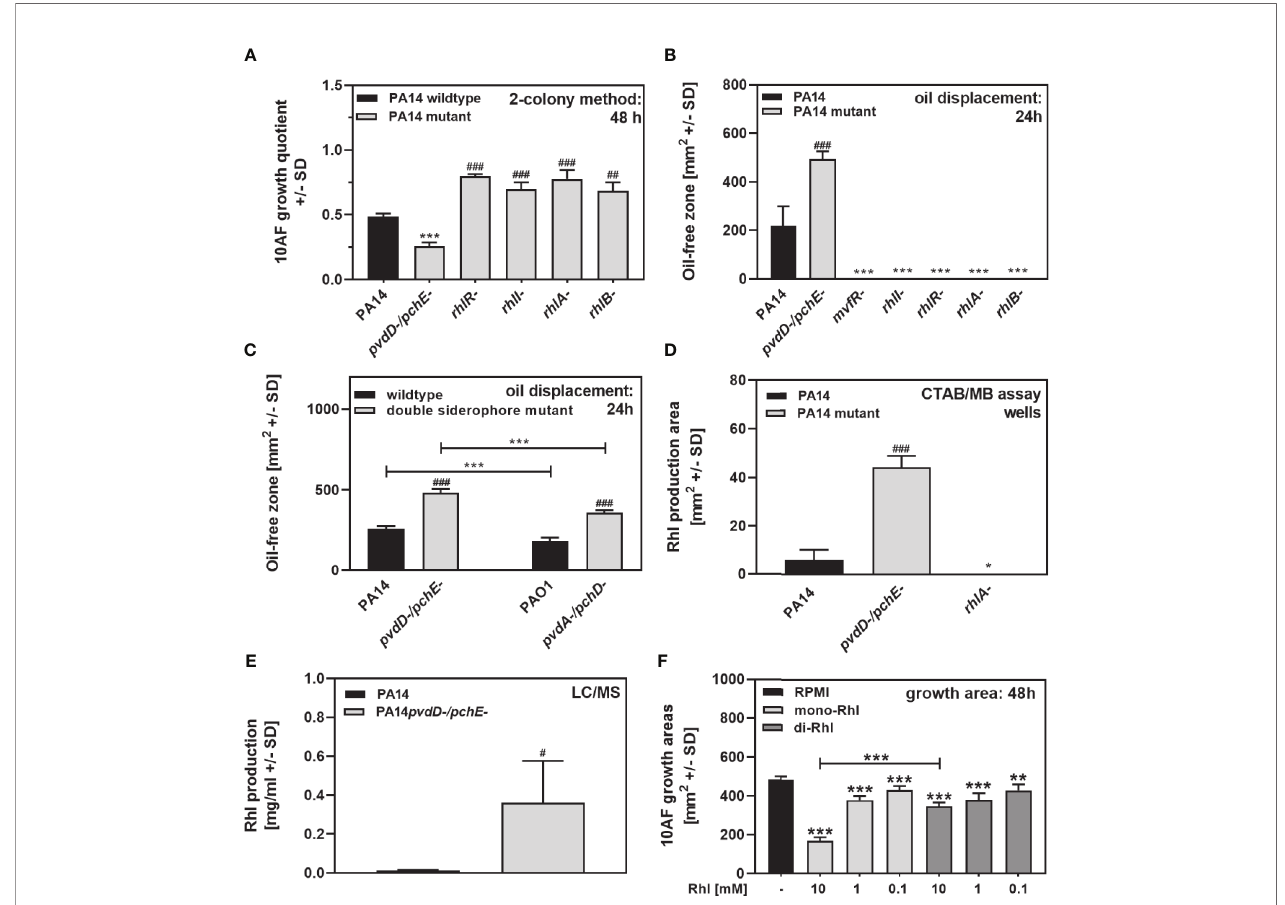
FIGURE 6 | Rhamnolipids have antifungal activity on agar. (A) Six-millimeter paper disks were placed on RPMI agar. Ten microliters of A. fumigatus 10AF conidia (10 7 /ml, prepared in RPMI) was placed on each disk, and 10 microliters of PA14 wild-type, PA14 pvdD-/pchE- , PA14 rhlR- , PA14 rhlI- , PA14 rhlA -, or PA14 rhlB- bacteria (10 9 /ml, prepared in RPMI) was placed 15 mm distant from the disks carrying 10AF. Plates were incubated for 48 h at 37°C, and growth quotients were determined by the two-colony method. Statistical analysis: Comparison: PA14 (black bar) vs. all other bars. (B) Ten-microliter droplets of PA14 wild-type, PA14 pvdD-/pchE -, PA14 mvfR- , PA14 rhlI- , PA14 rhlR- , PA14 rhlA- , or PA14 rhlB- bacteria (10 9 /ml, prepared in RPMI) were placed in the middle of 4-cm RPMI agar plates. Plates were incubated at 37°C for 24 h. An oil displacement test was performed. Comparison: PA14 (black bar) vs . all other bars. (C) Ten-microliter droplets of PA14 wild-type, PA14 pvdD-/pchE- , PAO1 wild-type, or PAO1 pvdA-/pchD- bacteria (10 9 /ml, prepared in RPMI) were placed in the middle of 4-cm RPMI agar plates. Plates were incubated at 37°C for 24 h. An oil displacement test was performed. Comparison: PA14 (black bar) vs . all other bars, or as indicated by the ends of the brackets. (D) Six-millimeter paper disks were placed on CTAB/MB agar. Ten microliters of PA14 wild-type, PA14 pvdD-/pchE- , or PA14 rhlA- bacteria (10 9 /ml, prepared in RPMI) was placed on the disks. Plates were incubated for 72 h at 37°C, and blue zones arround the disks were determined. Statistical analysis: t-test: Comparison: PA14 (black bar) vs . all other bars. (E) Rhamnolipid production by PA14 wild-type and PA14 pvdD-/pchE- was quanti fi ed by LC/MS as described in detail in Materials and Methods . (F) Six-millimeter paper disks were placed on RPMI agar. Ten microliters of A. fumigatus 10AF conidia (10 7 /ml, prepared in RPMI) was placed on each disk, and 10 µl of pure mono-ordi-rhamnolipids was added to the fi lter disks at 0.1, 1, or 10 mM. Plates were incubated at 37°C for 48 h, and fungal growth areas were determined. Comparison: PA14 (black bar) vs . all other bars, or as indicated by the ends of the bracket. Statistical analysis in (A – F) , t-test: one, two, or three asterisks or pound signs = p ≤ 0.05, p ≤ 0.01, and p ≤ 0.001, respectively. Asterisks represent signi fi cant increases; pound signs represent signi fi cant decreases in antifungal activity (A, F) or in rhamnolipid production (B – E)